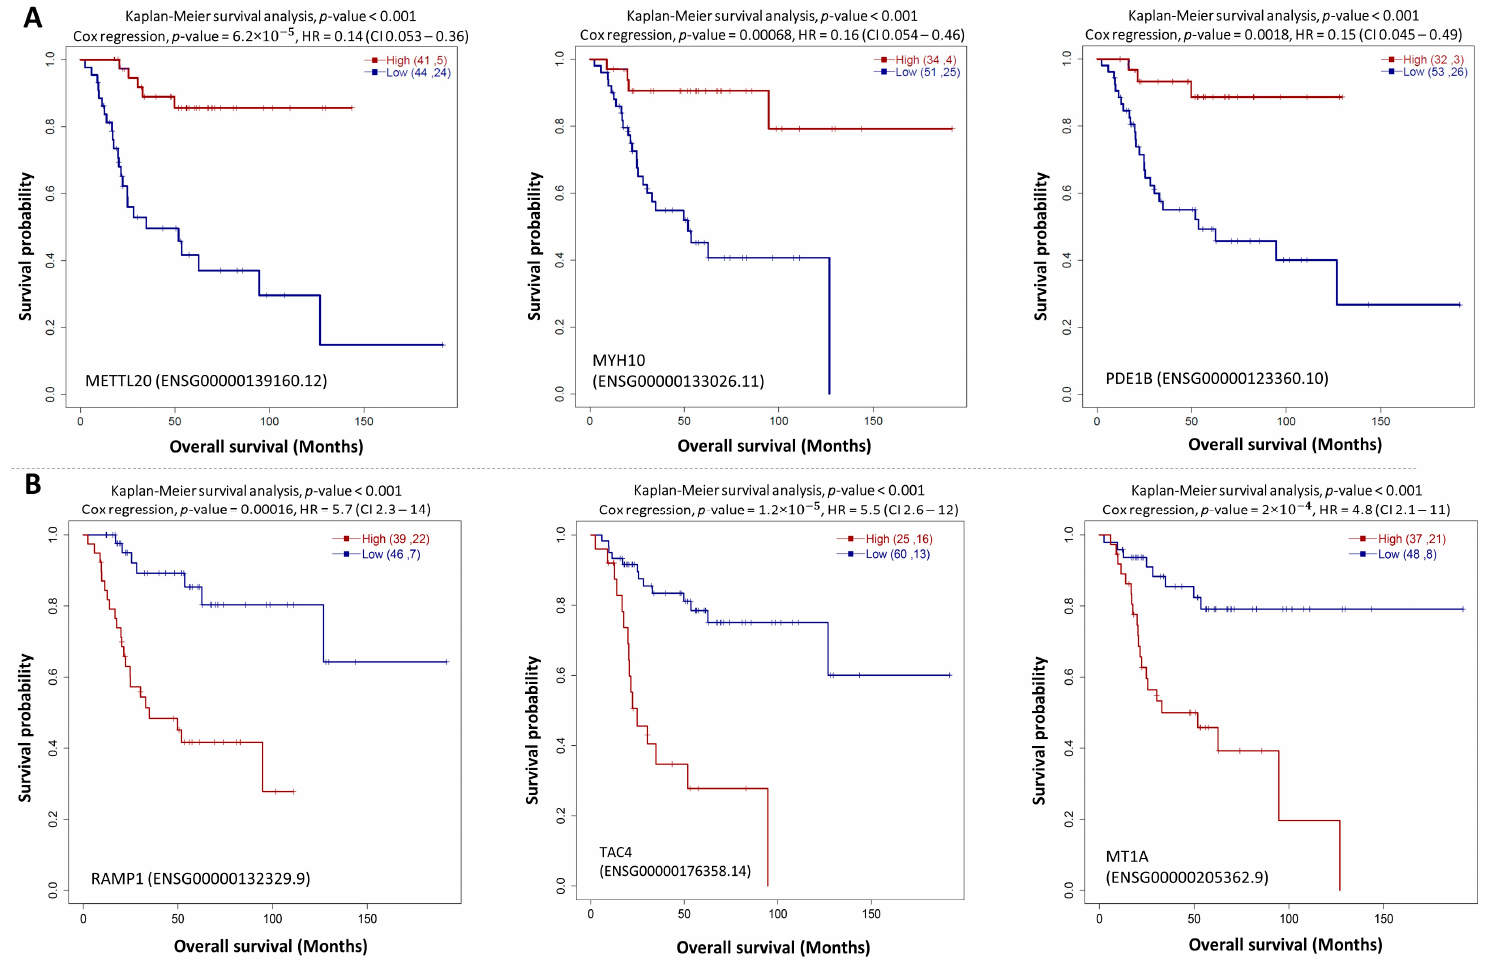
Figure 2. Kaplan-Meier plot for high vs low expression group in TARGET OS data with p -value from log-rank test and Cox regression model for genes, METTL20 , MYH10 , and PDE1B with HR < 1 ( A ), and genes, RAMP1 , TAC4 , and MT1 with HR > 1 ( B ).